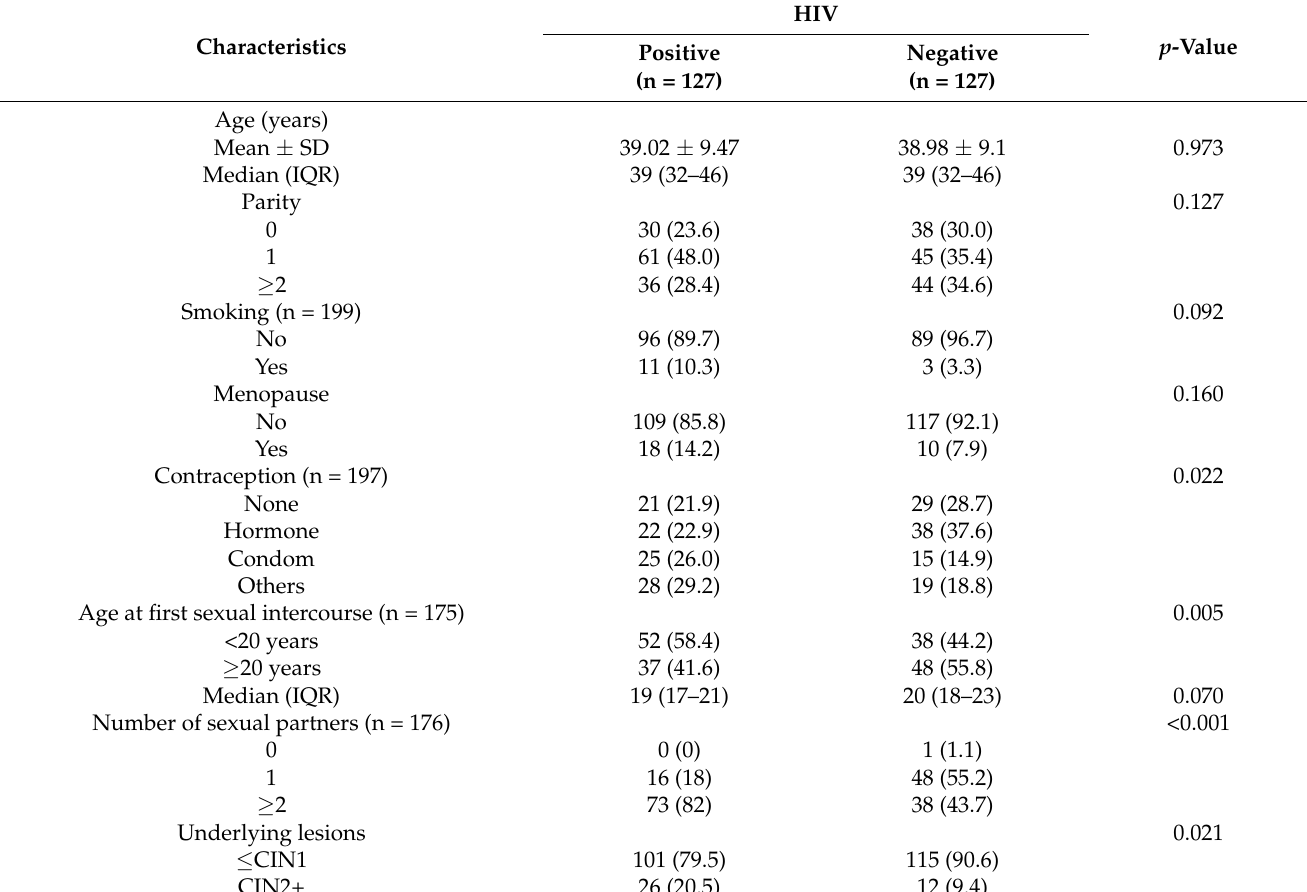
Table 1. Characteristics and underlying cervical lesions of the patients with LSIL. Cytology categorized by HIV status (n =